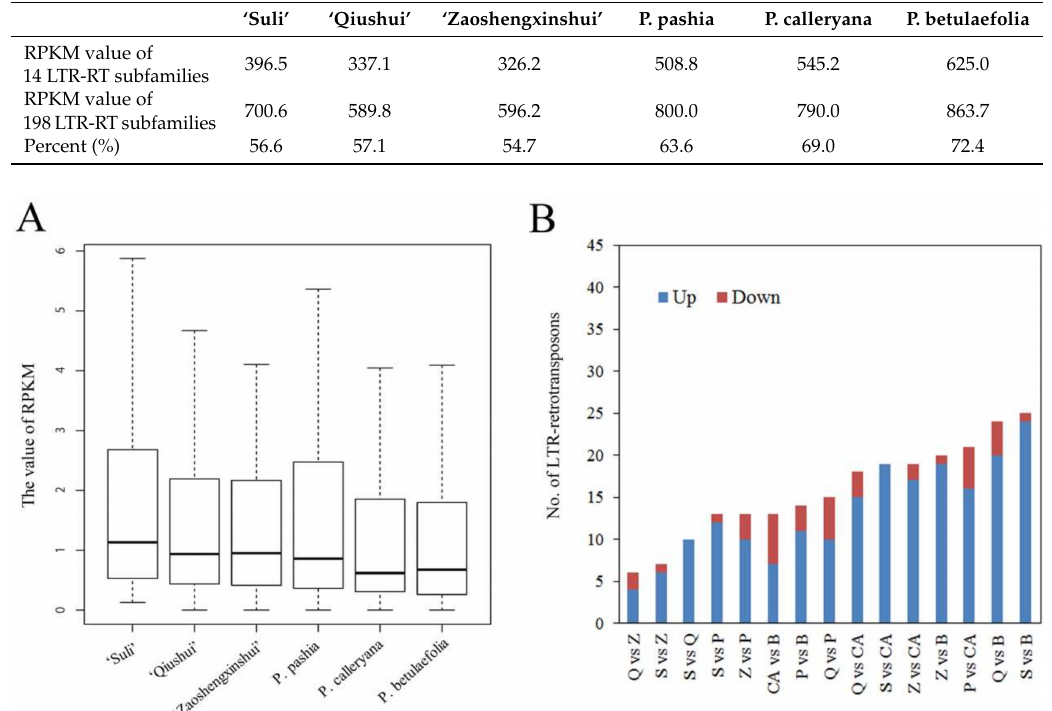
Table 2. The RPKM values of the 14 long terminal repeat retrotransposons (LTR-RT) subfamilies and all isolated LTR-RTs.